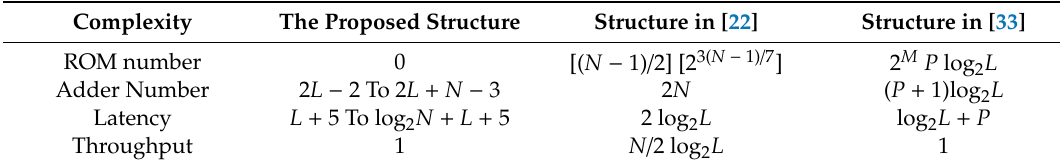
Table 2. The compassions of hardware complexity.